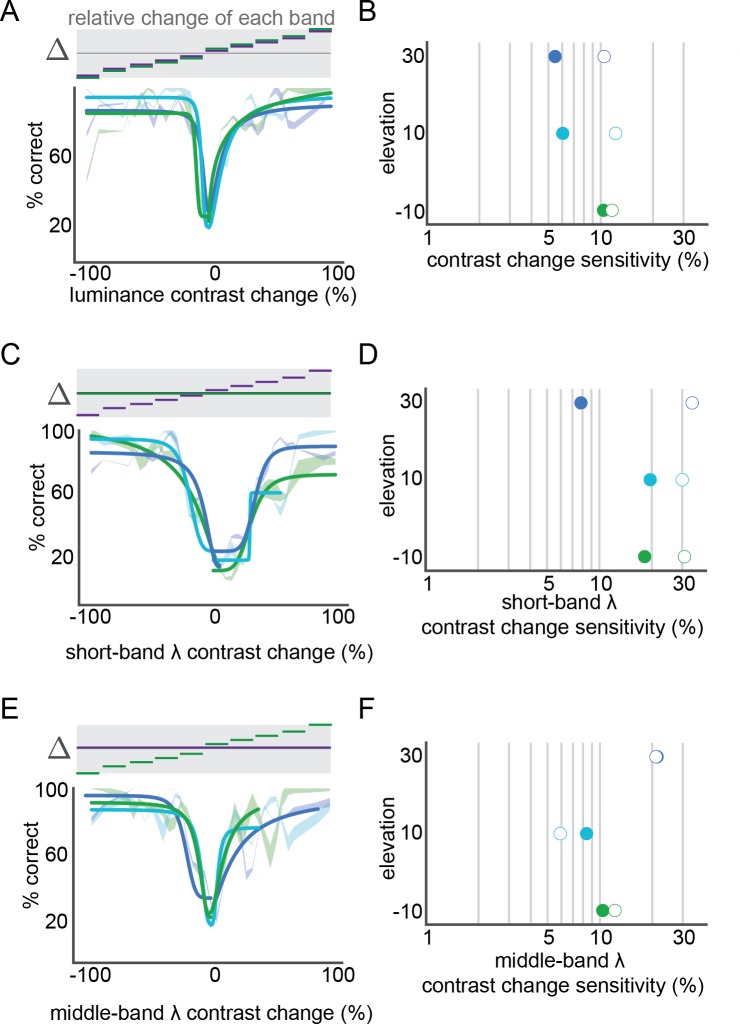
Short and middle wavelength band specific contrast sensitivity.(A) Performance of luminance contrast change detection at three elevations (green lines: −10°, light blue lines: 10°, dark blue lines: 30°). For each elevation, a fit with hyperbolic ratio function is shown overlaid on mean performance; mean performance line thickness shows S.E.M. across mice. The stimulus is schematized above the performance, showing the corresponding relative change in each wavelength band for each condition. (B) Contrast sensitivity at each elevation, from the fits in panel A; closed circles: decrements in contrast, open circles: increments in contrast. (C,D) short-band specific luminance contrast performance across elevation, as in panels (A,B). (E,F) middle-band specific luminance contrast performance across elevation, as in panels A,B.